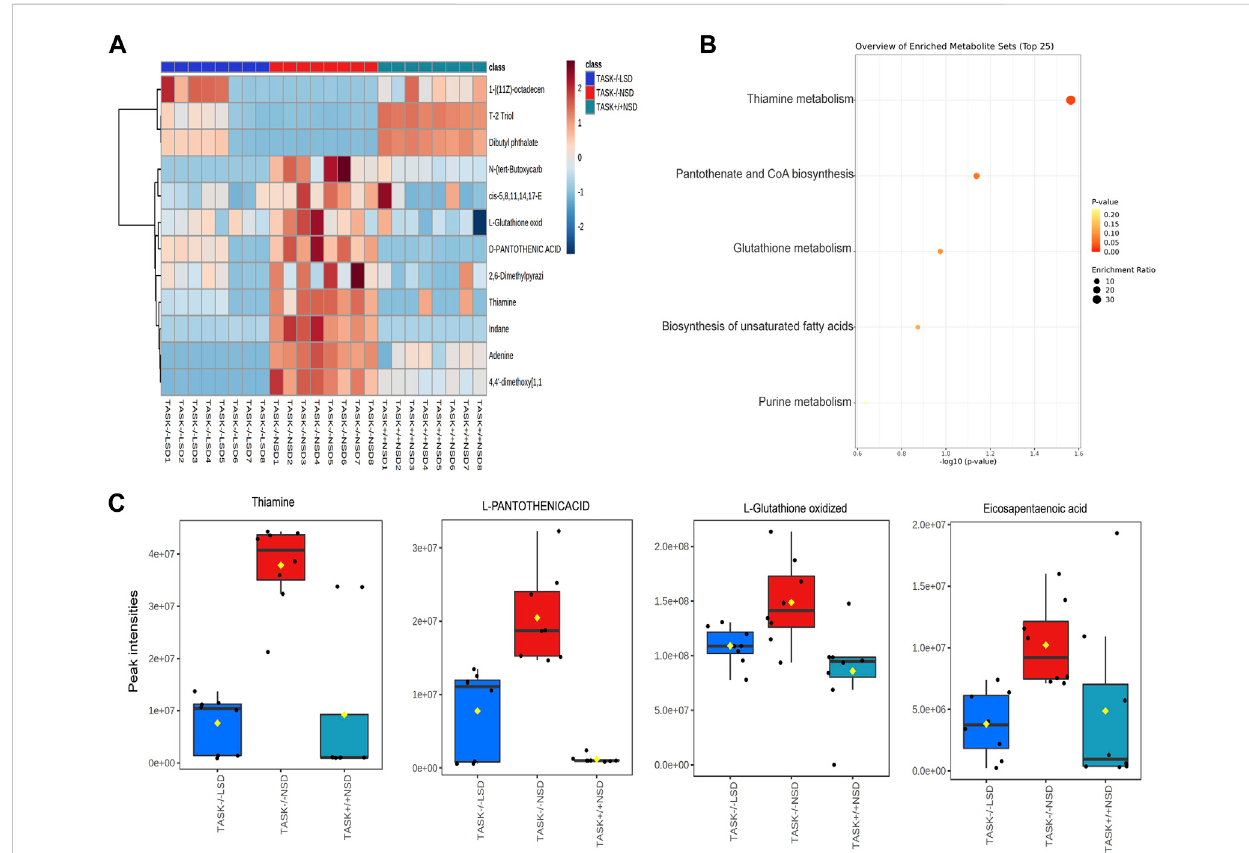
Metabolites that were signi fi cantly altered in TASK − / − mice and prevented by sodium restriction. (A) Heat maps summarize the metabolites signi fi cantlyregulatedinTASK − / − micecomparedtoTASK +/+ mice,andwhichwerereversedbythetwo-weekLSD( n =8ineachgroup, p < 0.05,one-way ANOVAwith Fisher ’ sLSDtest).A heatmap wasgeneratedusingPearson ’ schi-squared testfor distance measurementandtheWardtestfortheclustering algorithm. Colors on the heatmap indicate expression levels (red means high; blue means low). (B) The bubble plot displays metabolic pathway enrichmentanalysis ofthose signi fi cantly reverted metabolites inresponseto theLSDfrom (A) . Box-and-whiskerplots summarize thenormalizedvalues (C) . The Box-and-whisker plots include a central box that shows the interquartile range and a median line inside the box. Normal diet TASK +/+ mice